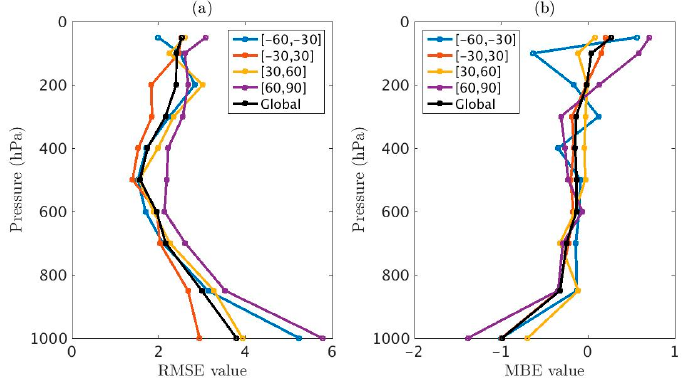
Figure 7. HIRS derived temperature (°C) compared to 2013–2014 (in which data are not used for bias calibration scheme development) radiosonde (1000–400 hPa) and GPS RO (300–50 hPa) profiles for global and latitude bands for ( a ) RMSE and ( b ) MBE (HIRS values minus radiosonde or GPS RO values).